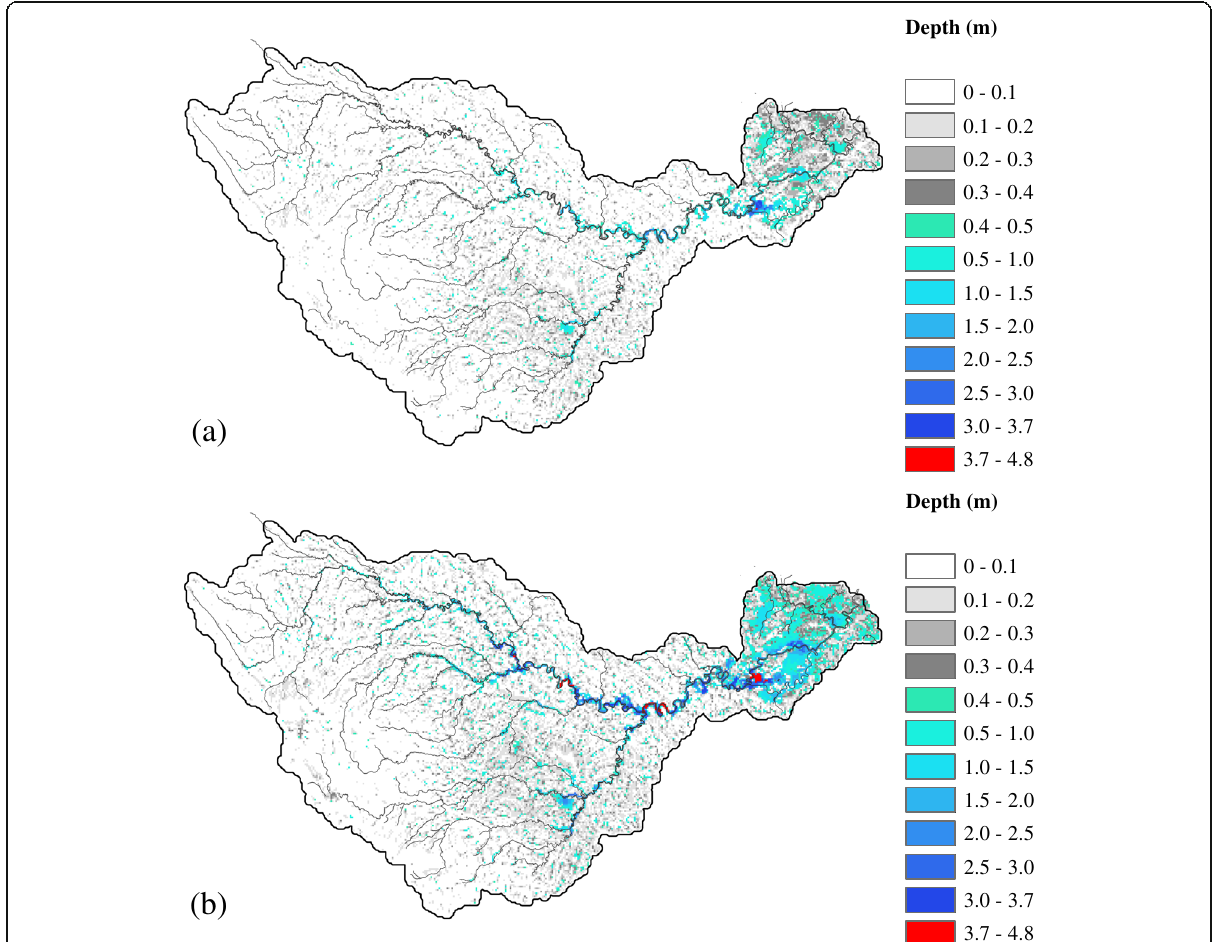
Fig. 12 Projection of NHRCM annual maximum inundation depth distribution a under present and b in future climate